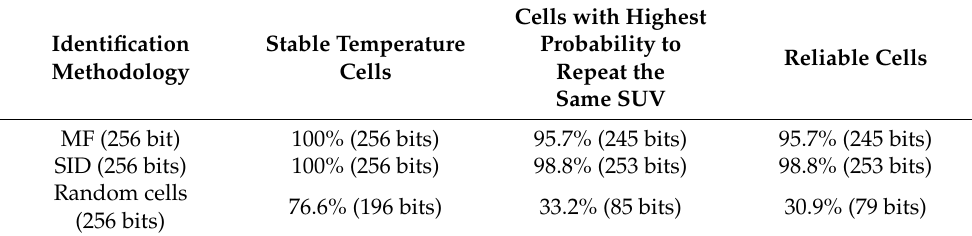
Table 1. Selection Table 1. Selection results.